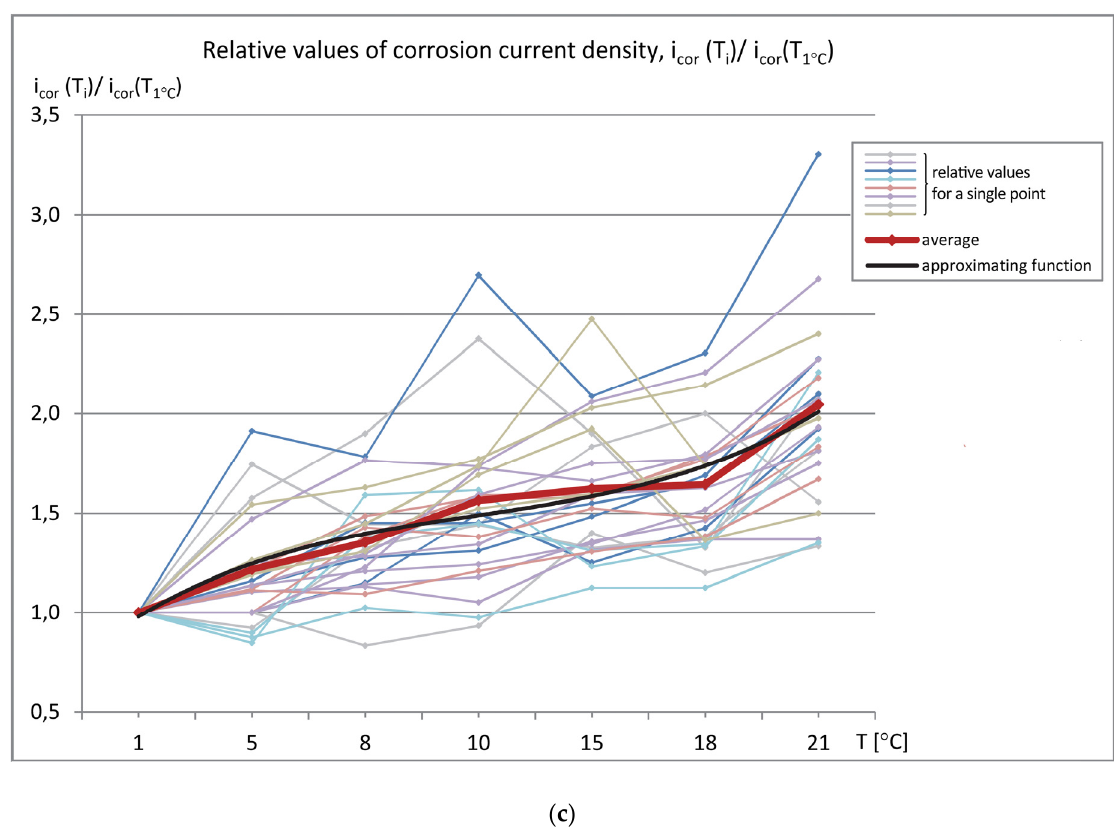
Figure 7. Relative values of measured parameters on samples at different temperatures.; a) Figure7. Relativevaluesofmeasuredparametersonsamplesatdi ff erenttemperatures; ( a )reinforcement stationary potential, ( b ) concrete cover resistivity, ( c ) corrosion current